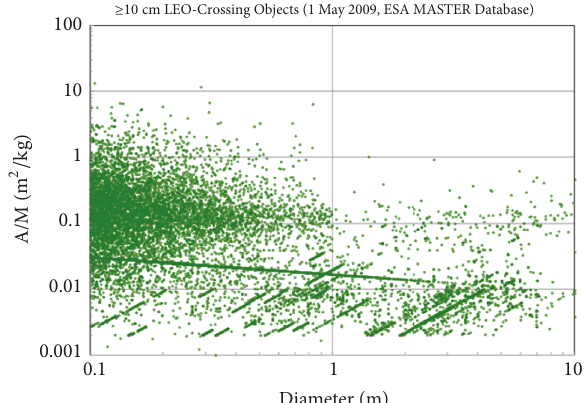
Figure 14: Area-to-mass ratio distributions of the initial population used in IADC comparison